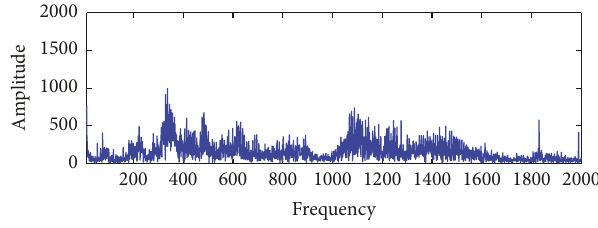
Figure 17: The FT of the vibration signal presented in Figure 16.